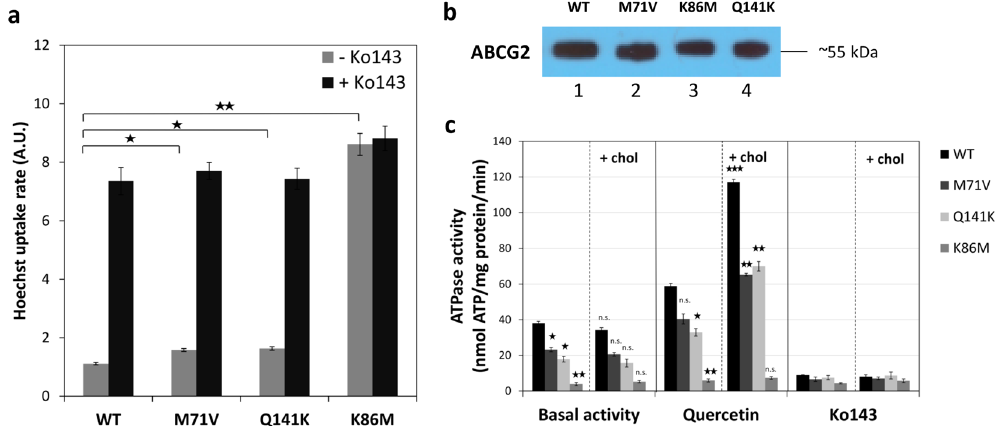
Figure 3. Functional analysis of ABCG2 and its variants in cellular expression systems. (Panel a) ABCG2- dependent Hst dye extrusion in HEK 293 cells. The initial slopes were determined from the kinetic curves of cellular dye accumulation assessed by flow cytometry in the absence and presence of Ko143, a specific inhibitor of ABCG2 inhibitor (n = 3, ± SE, significance determined by Student’s t-test). (Panel b) Expression levels of ABCG2 variants (Wt, M71V, Q141K, and K86M) in isolated Sf9 membranes, as measured by Western blotting, using the BXP-21 antibody. The different proteins examined in the Western blot were developed by the respective antibodies and cropped from the indicated parts of the same gel and blot. (Panel c) ABCG2- ATPase activity in isolated Sf9 membranes, expressing the ABCG2 (Wt, M71V, Q141K, and K86M) variants. Vanadate-sensitive ATPase activity in the absence or presence of membrane cholesterol was measured, either in the absence of additional compounds (basal activity), in the presence of 10 µ M quercetin, providing maximum drug-stimulated activity, or in the presence of 5 µ M Ko143. ( ± SEM, significant differences were determined with Student’s t-test) In the left panels (without cholesterol), the mutant variants were compared to wild type, whereas in the right panels (with cholesterol) cholesterol-treated membrane preparations were compared to the corresponding untreated samples. * p < 0.05, ** p < 0.01, *** p <